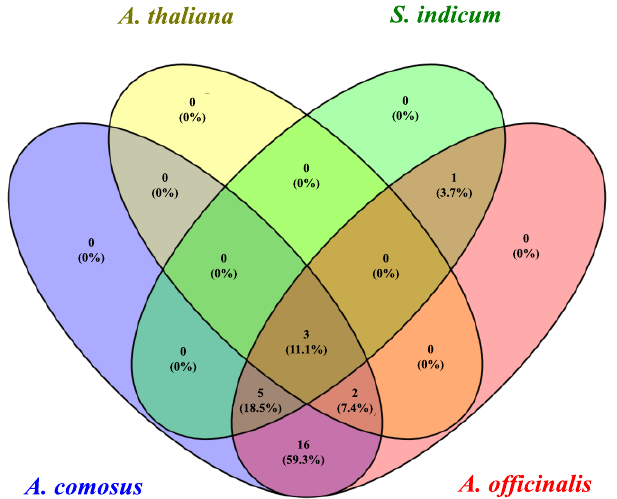
Figure 7. Venn diagram of the identical and different NAC genes among A. officinalis , A. thaliana , S. indicum , and A. comosus .